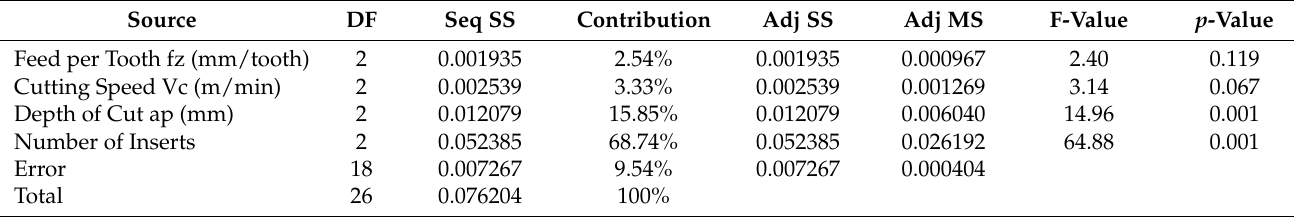
Table 5. ANOVA results for average surface roughness .